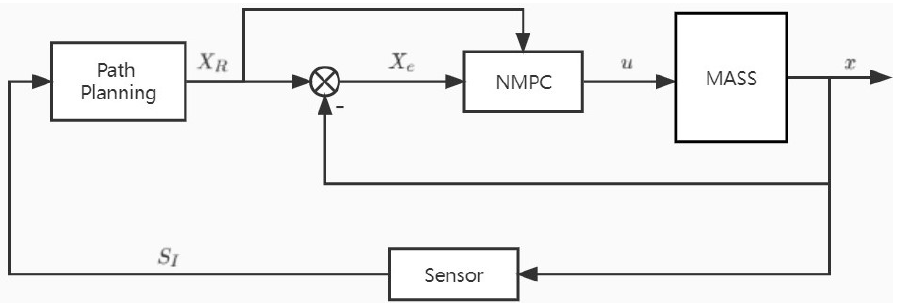
Figure 6. Closed-loop